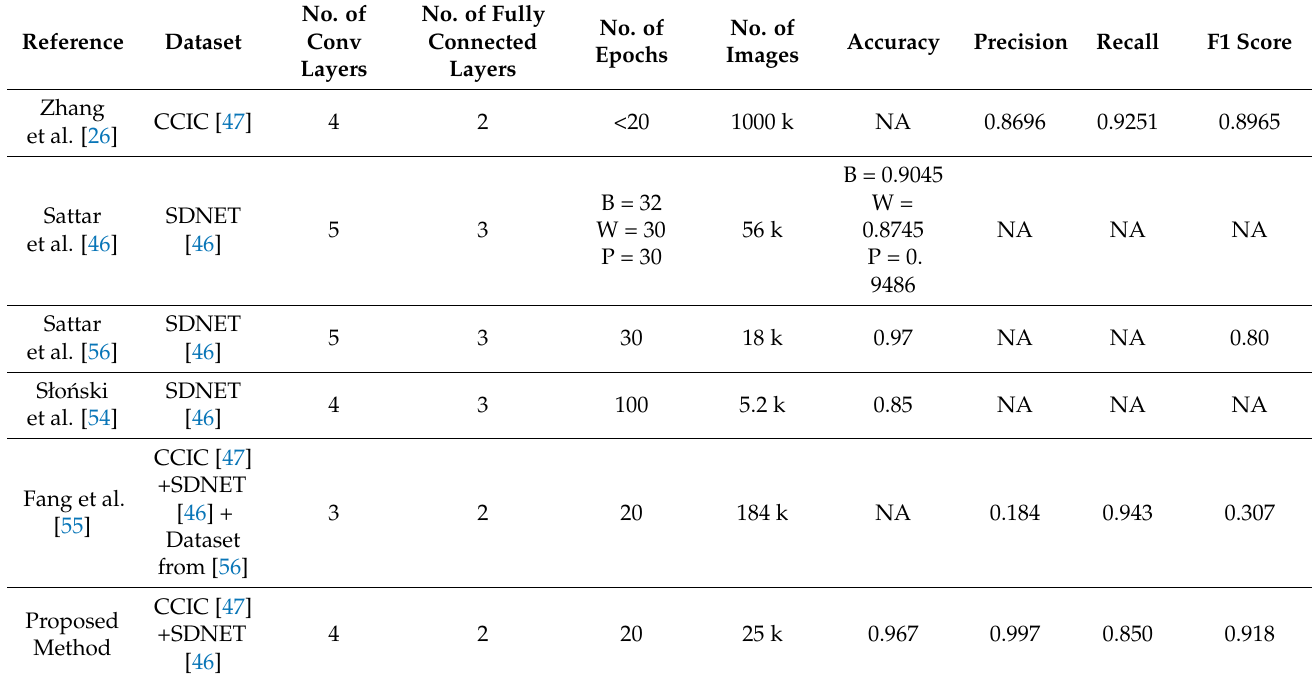
Table 6. Comparison of the proposed work with other CNN